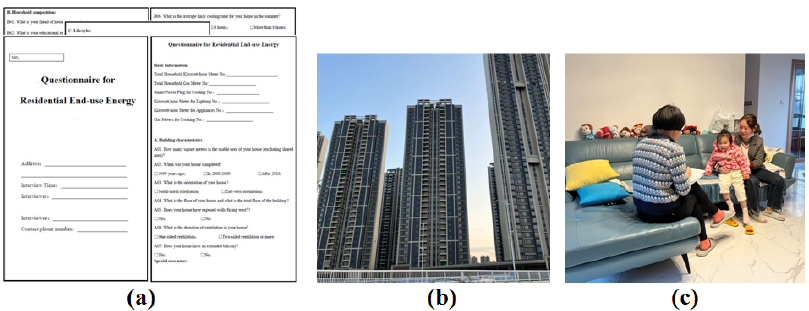
Figure 2. Residential information collection through a field survey: ( a ) survey form, ( b ) outward appearance of a residential building, ( c ) interview with households. Table 2. Details of independent variables.